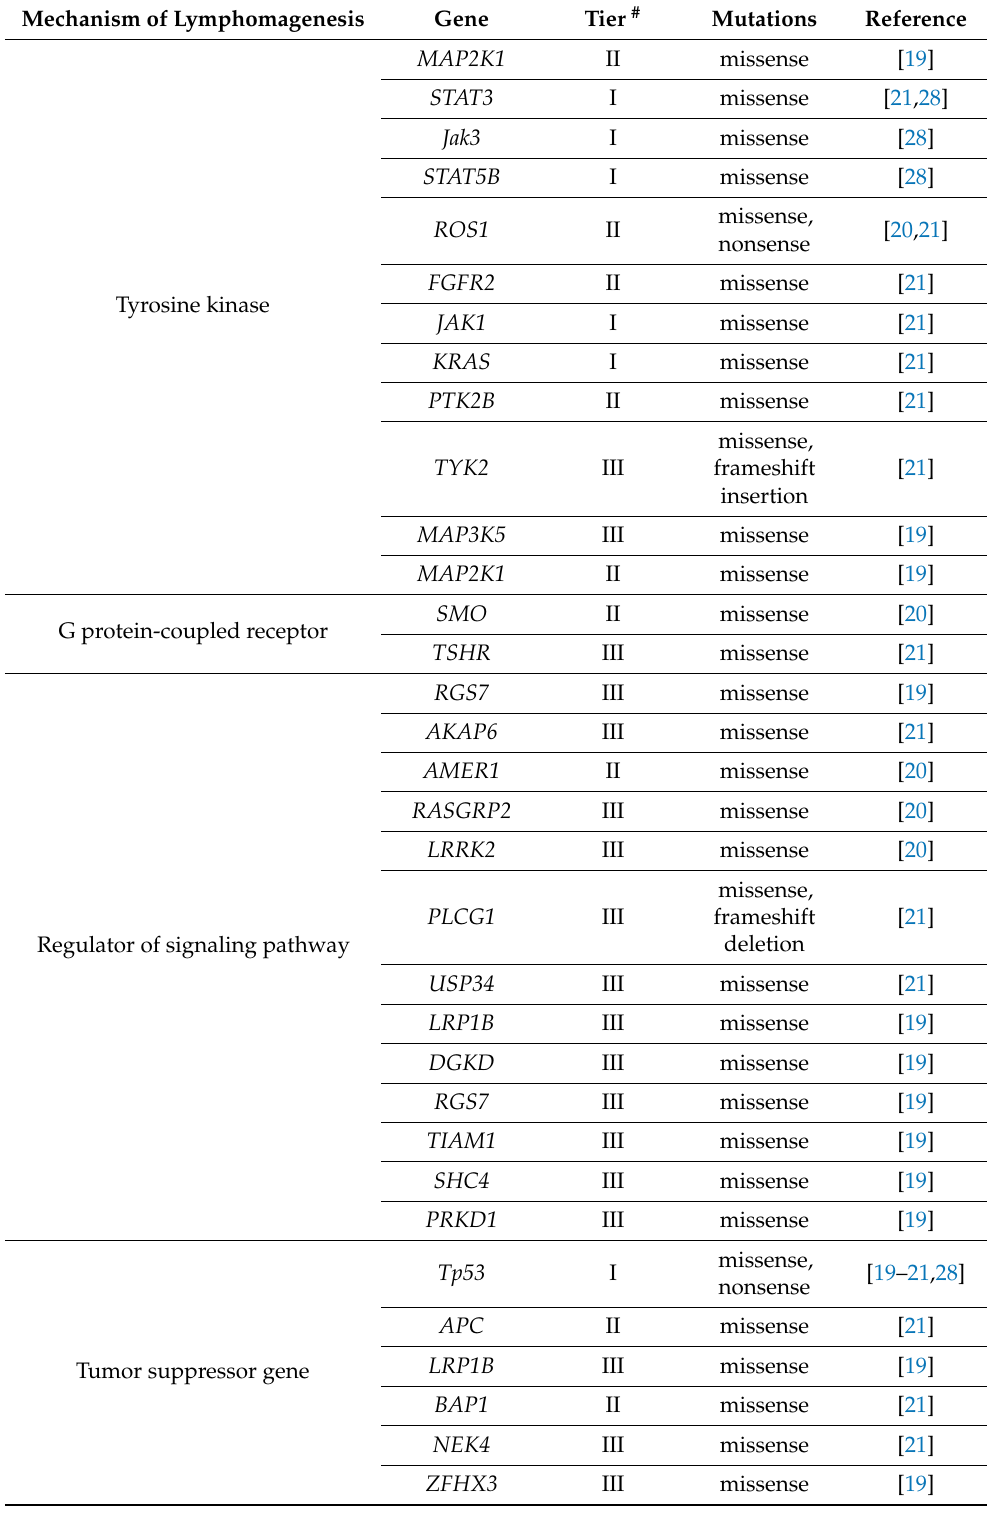
Table 1. Cont. Mechanism of